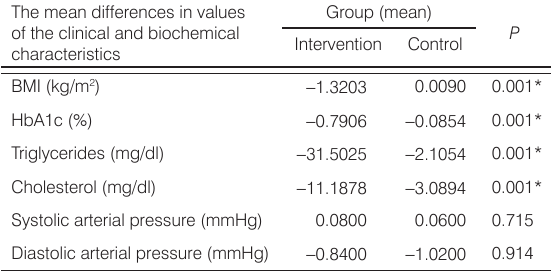
Table 5. Comparison of the mean differences in values of the clinical and biochemical characteristics of the participants before and after the intervention.